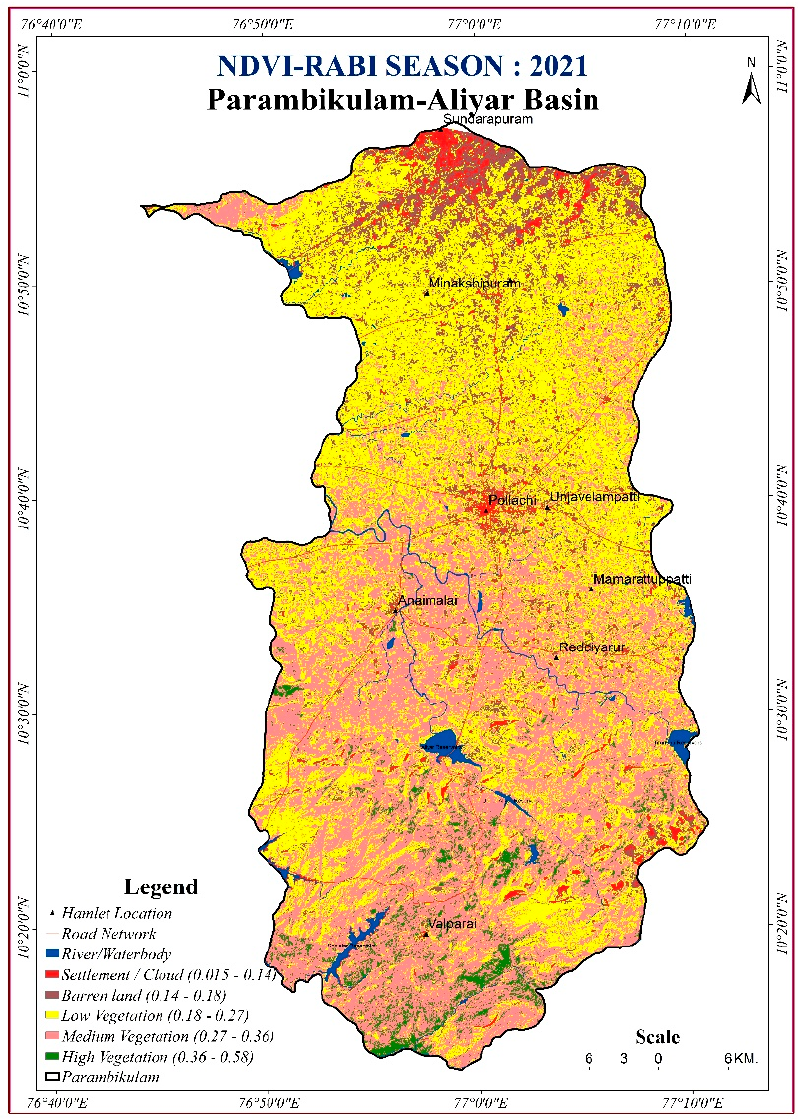
Figure 8. Mean NDVI for groundnut crop growing period, Rabi season (2021) in PAP. Normalized difference water index (NDWI) uses both the bands in near infrared re- gion and is very sensitive to liquid water content of vegetation canopy and rainfall. Many researchers have attempted to understand the sensitivity of NDWI in detecting and moni- toring the agricultural drought situations as NDVI shows a lagged relationship with rainfall distribution. NDWI5 images efficiently picked up the higher water stress in Khariff season than in Rabi, which is evidenced by more yellowness in the images (Figures 9 and 10). It is found from the real time data that more dry spells were present during June, July and September 2021 than in Rabi season. This study concludes that real time data combined with satellite-derived MODIS NDVI, NDWI data can be well utilized for regional level agricultural drought detection and monitoring for early warning [35]. Moreover, the major elements of a drought monitoring and early warning systems include knowledge of the risk, drought monitoring, dissemination of early warning to relevant stakeholders and preparedness and ability to